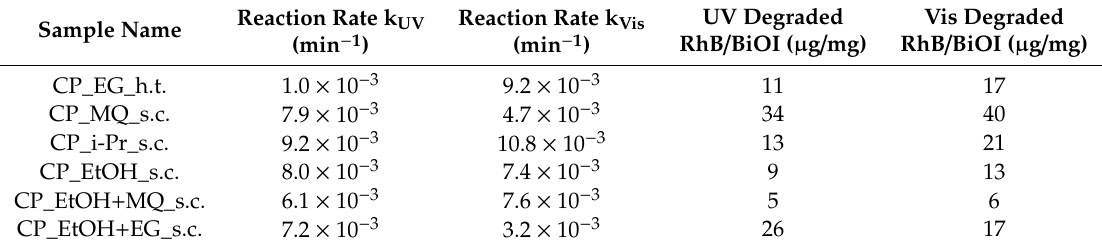
Table 3. Different approaches to the photocatalytic activity. The reaction rate approached the activity from the RhB site, while the mass normalized activity approached from the BiOI site.